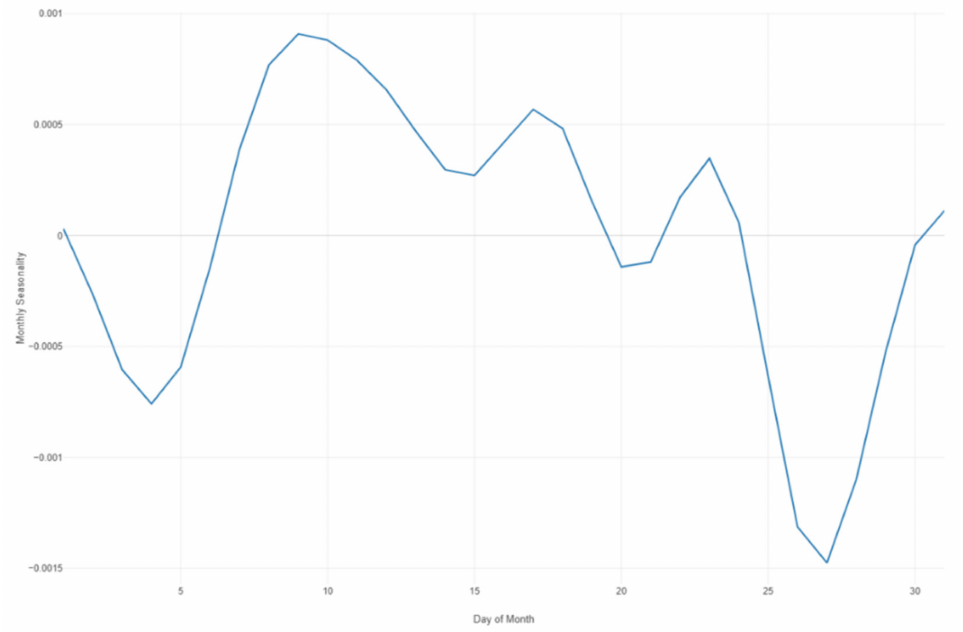
Figure 34. Prophet forecast monthly seasonality.